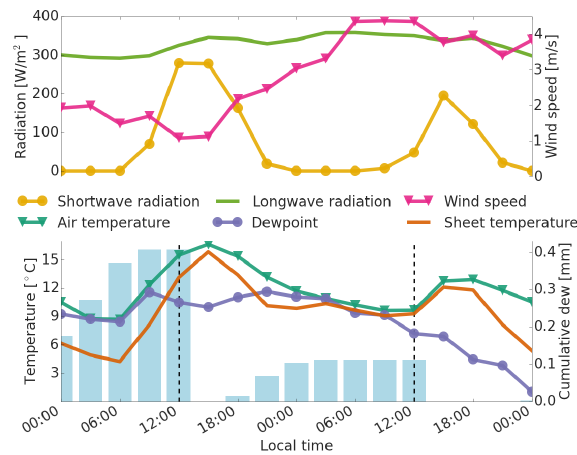
Figure 1. An example of modelled dew formation events on two consecutive days in September 2000 in Helsinki, Finland. The short-wave and long-wave radiation, wind speed, air temperature and dew point are input from the ERA-Interim data set. Note that the cumulated amount of dew (vertical bars) is reset daily at local noon (dashed vertical lines). All data are in 3h